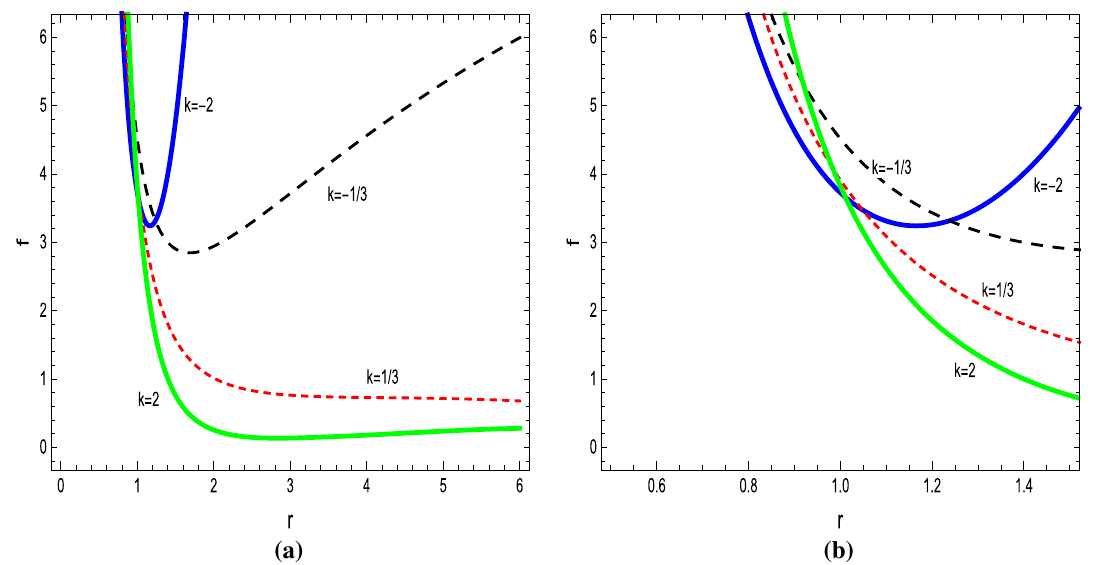
t = 2, n = − 1, ω = − 0 . 5 γ = 5, V 0 = 0 . 1, η = 1, E 1 = 1 . 42 × 10 − 13 , E p = 1 . 221 × 10 19 . b Representsthezoomedrangeoftheouterhorizon obtained in